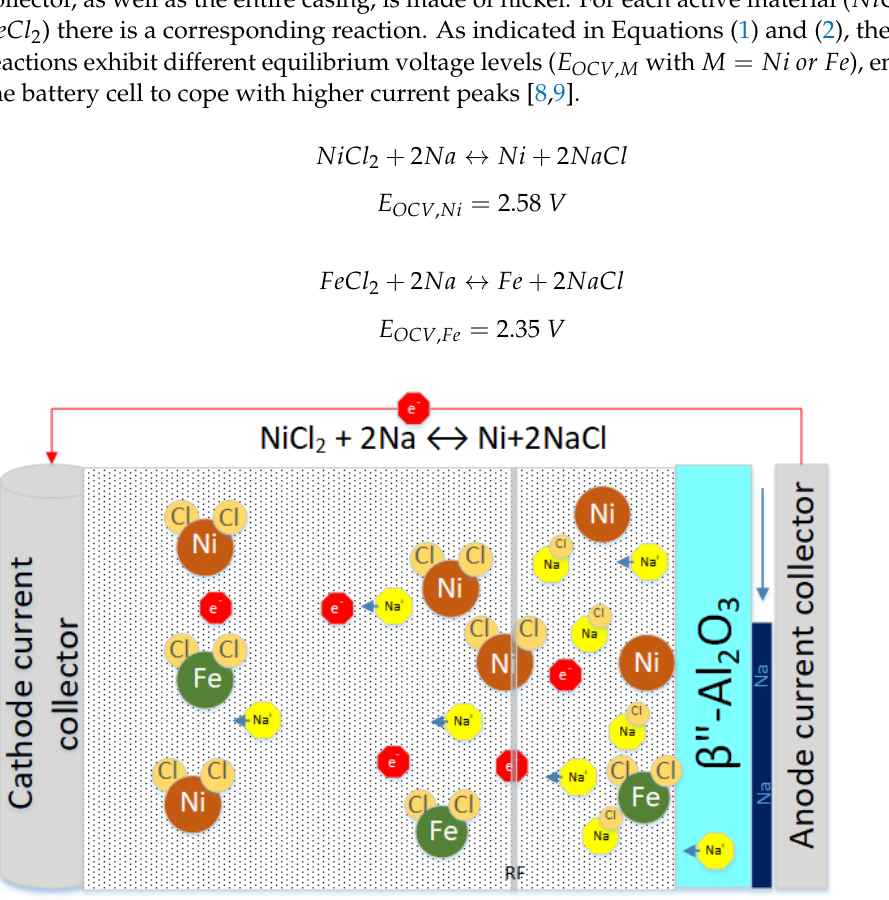
Figure 1. Reaction scheme during NiCl 2 and FeCl 2 reduction inside the cathode space, RF (reac- tion